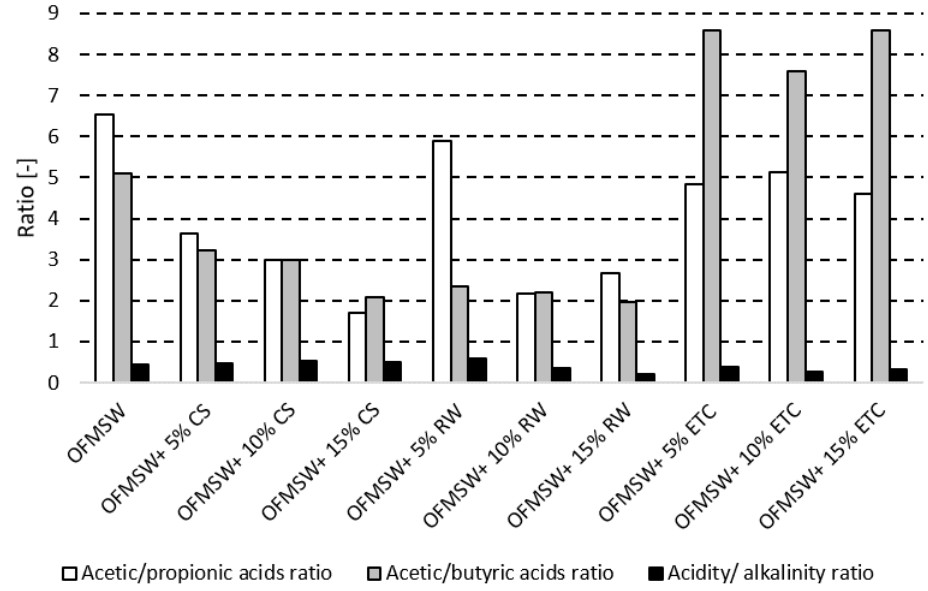
Figure 2. Fatty acids’ concentrations and acidity/alkalinity ratios for single substrate AD with the OFMSW and the AD with addition of different types of co-substrates: corn stillage (CS), restaurant wastes (RW), and effluents from the cleaning of chocolate transportation tanks (ETC).